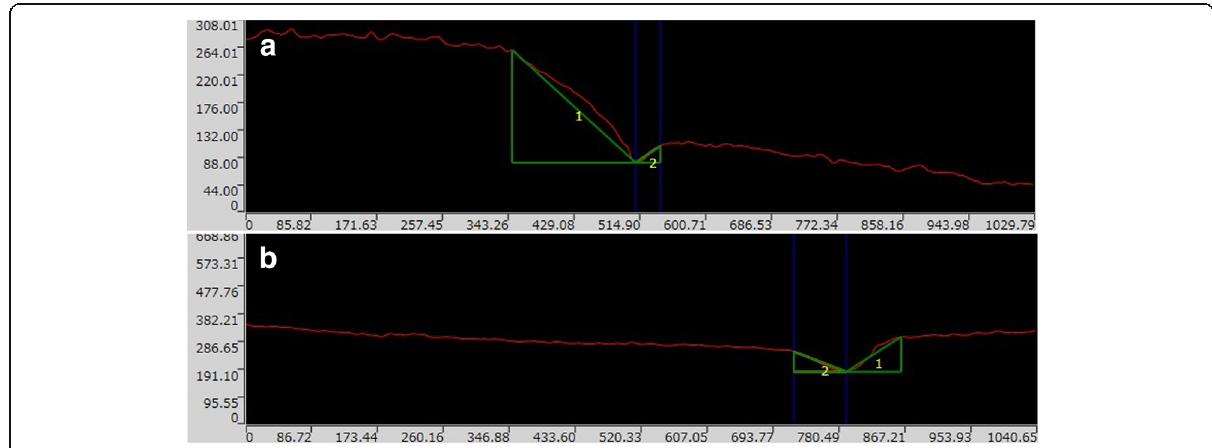
Fig. 7 a , b (The marginal discrepancy pattern for group CR and M4M). a Group CR (1: Ceramic surface, 2: CR surface) Units of the axis are in μ m. b Group M4M (1: Ceramic surface, 2: M4M surface) Units of the axis are in μ